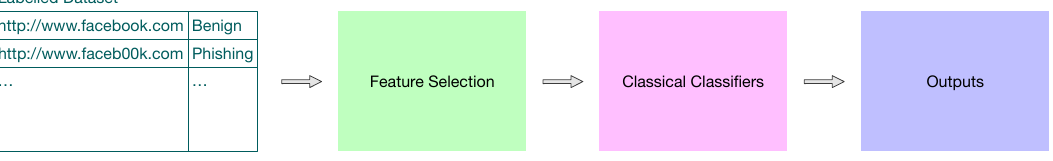
Figure 5. The general process of a classical supervised learning-based malicious website detection method.